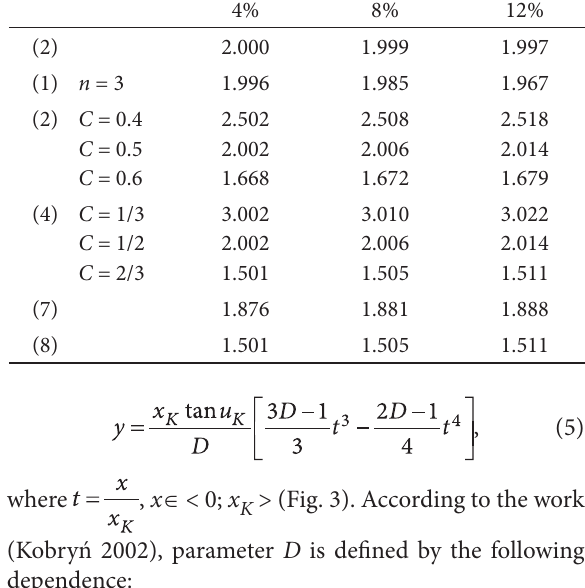
Fig. 4. General transition curves in Cartesian coordinate system (Kobryń 2002) Table 1. Necessary extensions of individual tangents with reference to circular arc tangent